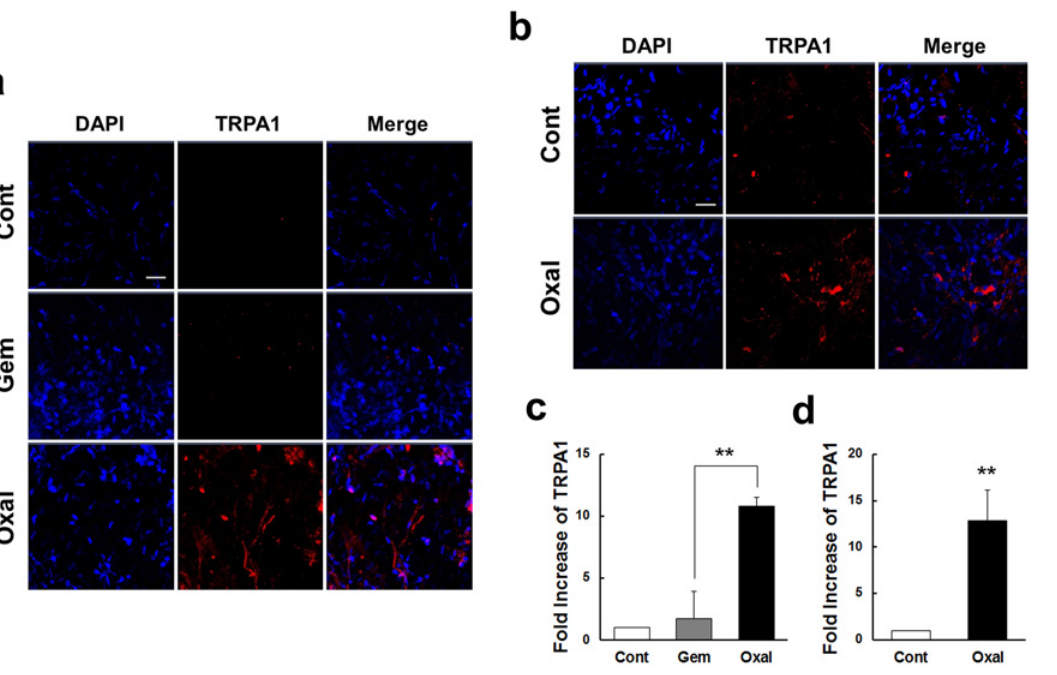
Fig 6. TRPA1 mRNA and protein expression in DRG from mice after short-term (30 days) (a, c) and long-term (60 days) (b, d) exposure to oxaliplatin. DRG tissues from Cont (5% dextrose), Gem (gemcitabine, 100 mg/kg), and Oxal (oxaliplatin, 3 mg/kg) groups were harvested at day 4 or 5 after final infusion with reagents. (a, b) Immunofluorescent staining for protein expression was conducted on whole DRG tissues with anti-TRPA1 (red). Nuclei were stained with DAPI (blue) and visualized using a confocal scanning microscope. TRPA1 protein was increased significantly in the Oxal group. (c, d) The relative ratio of TRPA1 mRNA measured by quantitative real-time PCR increased significantly in the Oxal group compared with tissues from the Gem (c) and Cont (c, d) groups. TRPA1 levels are expressed as fold changes after normalizing to 28S RNA. Assays were conducted in triplicate, and results are representative of three independent experiments. Values are expressed as the mean ± SEM ( n = 6 per group). ** p < 0.01 compared with the gemcitabine or control group. Scale bar = 10 μ m for all